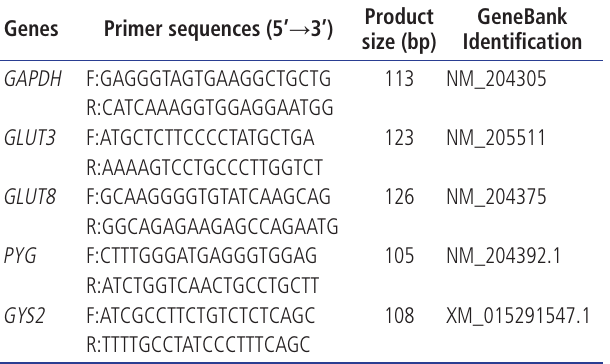
GAPDH, glyceraldehyde-3-phosphate dehydrogenase; GLUT3, glucose transporter 3; GLUT8, glucose trans-porter 8; PYG, glycogen phosphorylase; GYS2, glycogen synthase.